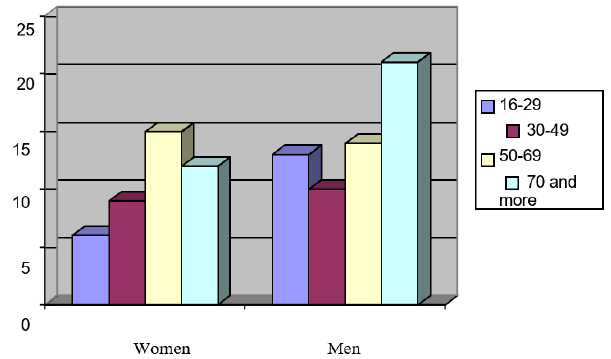
Figure 2. Percentage distribution of age of the respondents.